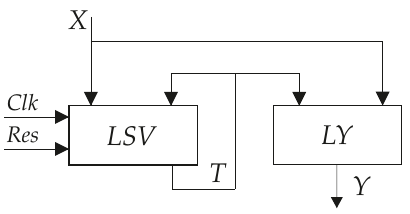
Figure 3. Structural diagram of LUT-based FSM U 1